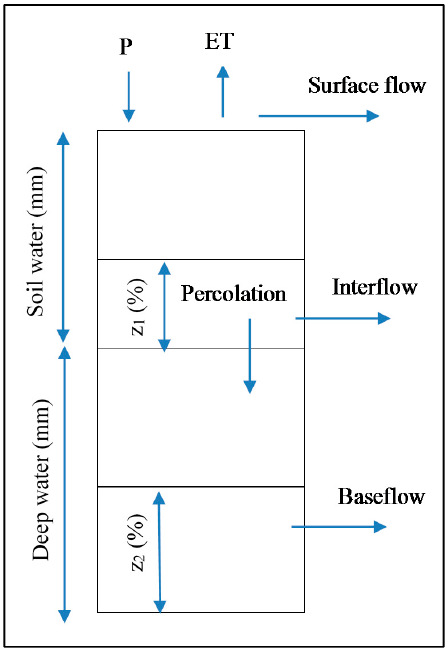
Figure 3. Conceptual diagram of a two-bucket hydrological model. ET: evapotranspiration; z 1 and z 2 are upper soil layer and lower soil layer (m) respectively.